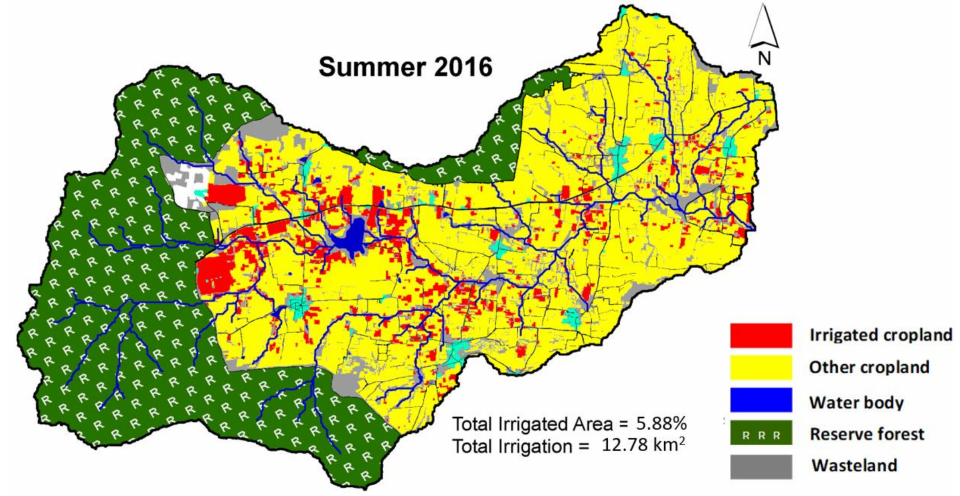
Figure 12. Classification of summer season irrigated cropland for